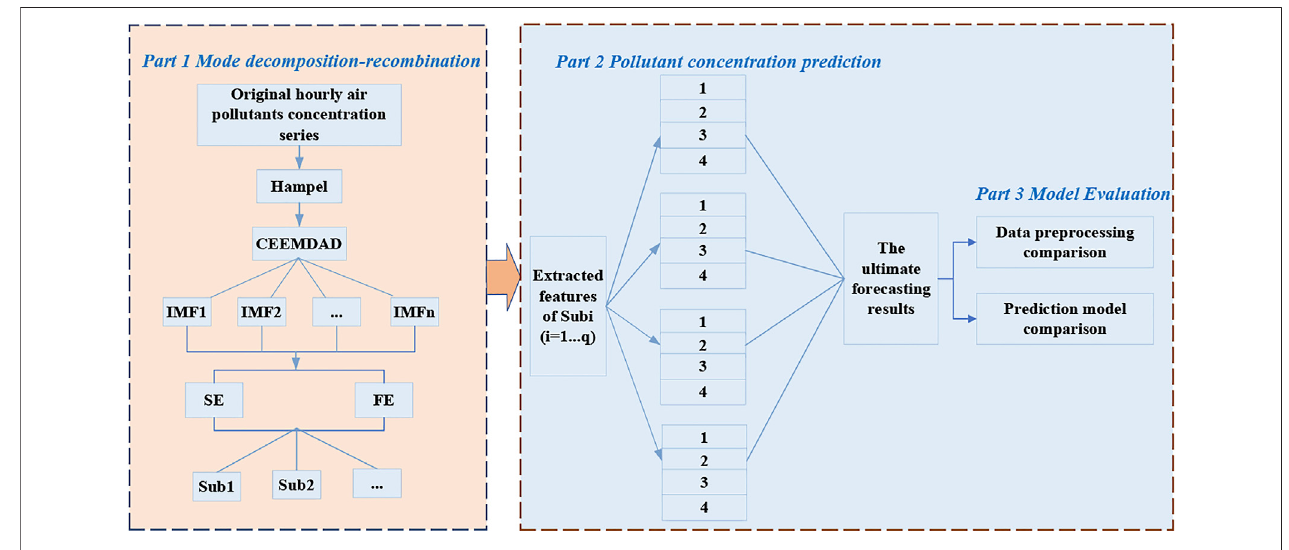
FIGURE 1 | The framework diagram of the hybrid